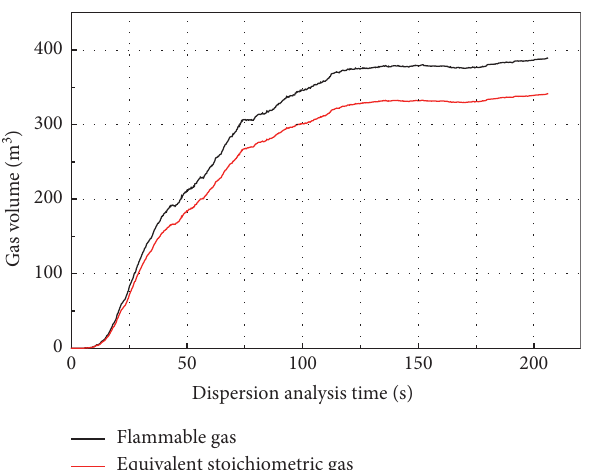
Figure 21: Comparison between volumes of flammable gas and equivalent stoichiometric gas for a leak scenario.